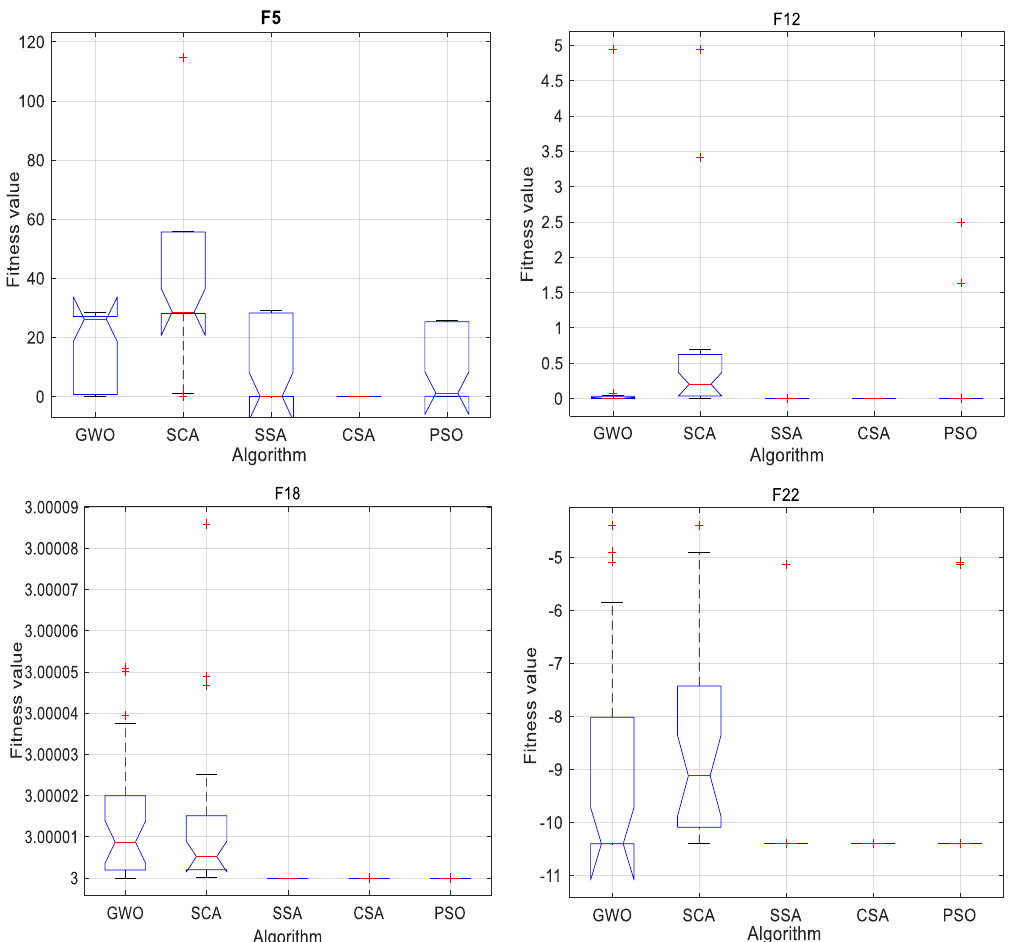
Figure 4. Convergence curves of the applied algorithms.